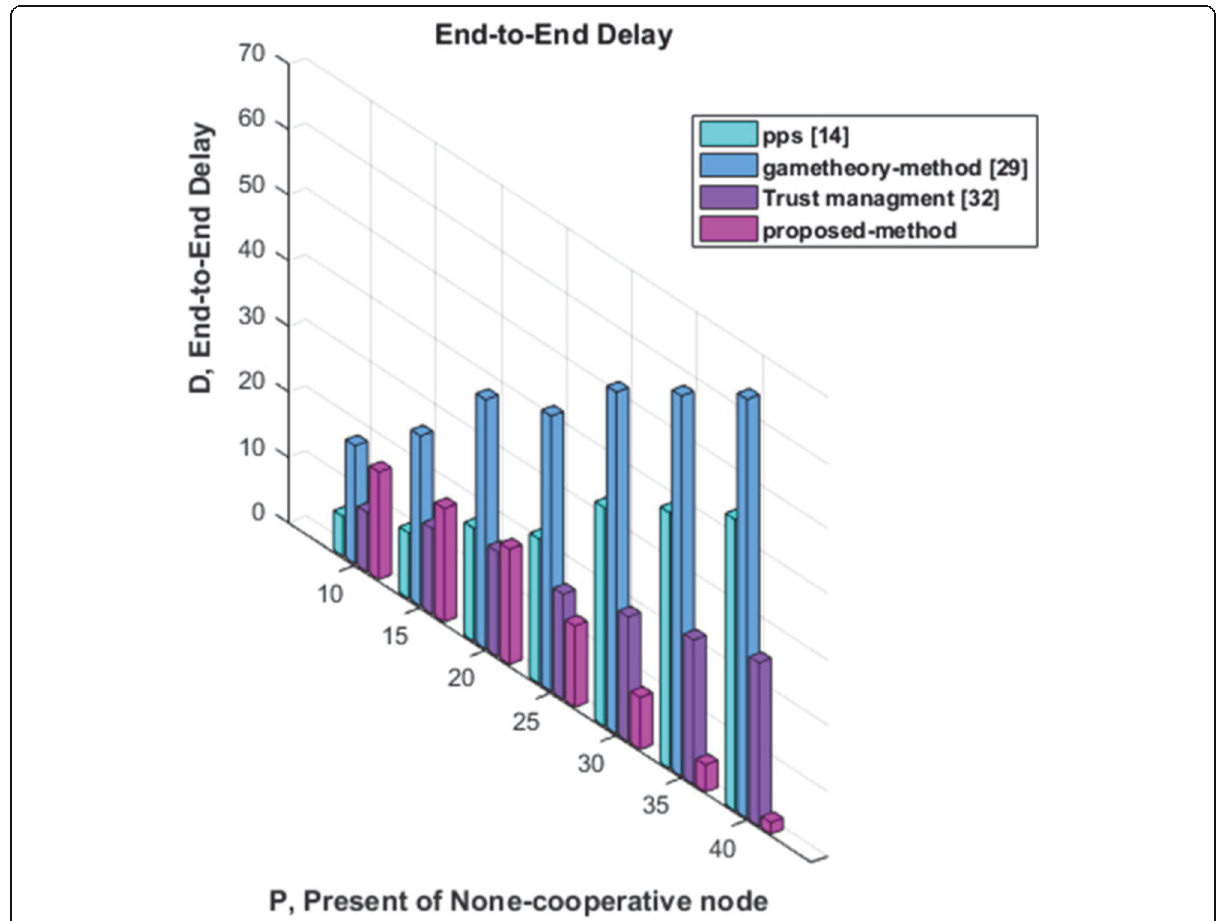
Fig. 13 Comparison of the average end-to-end delay by a different